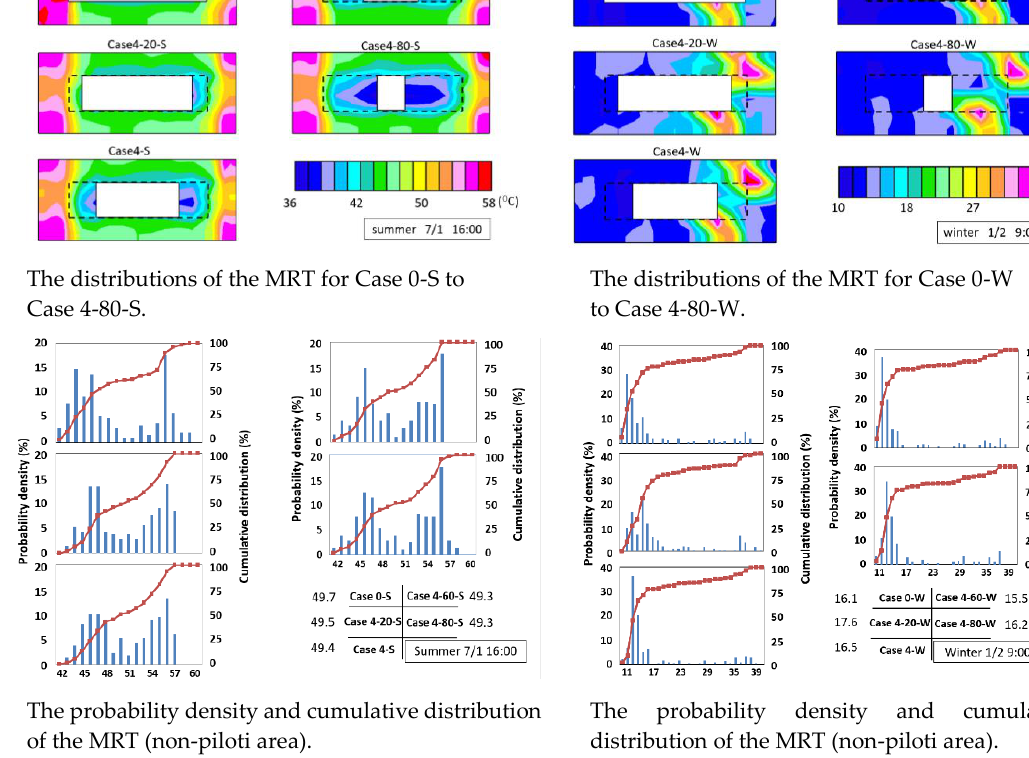
Figure 13. The simulation results of the MRT.